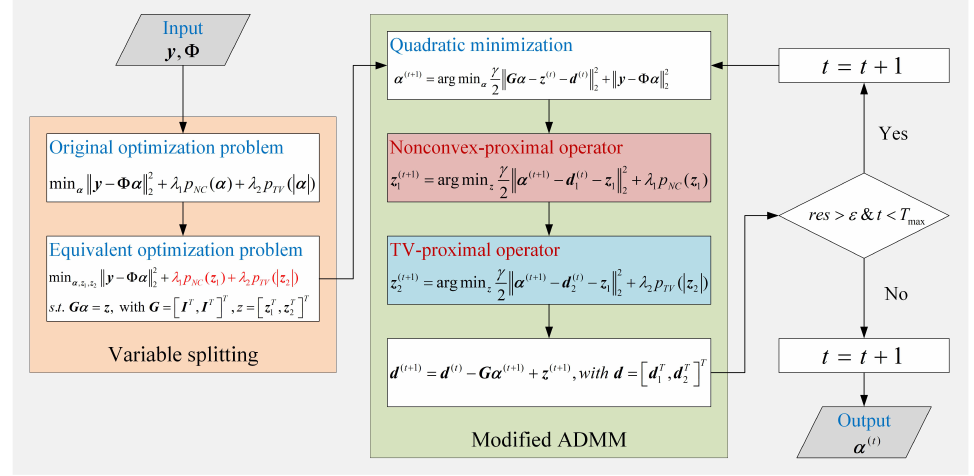
Figure 2. Flow chart of the proposed algorithm combining variable splitting and modified